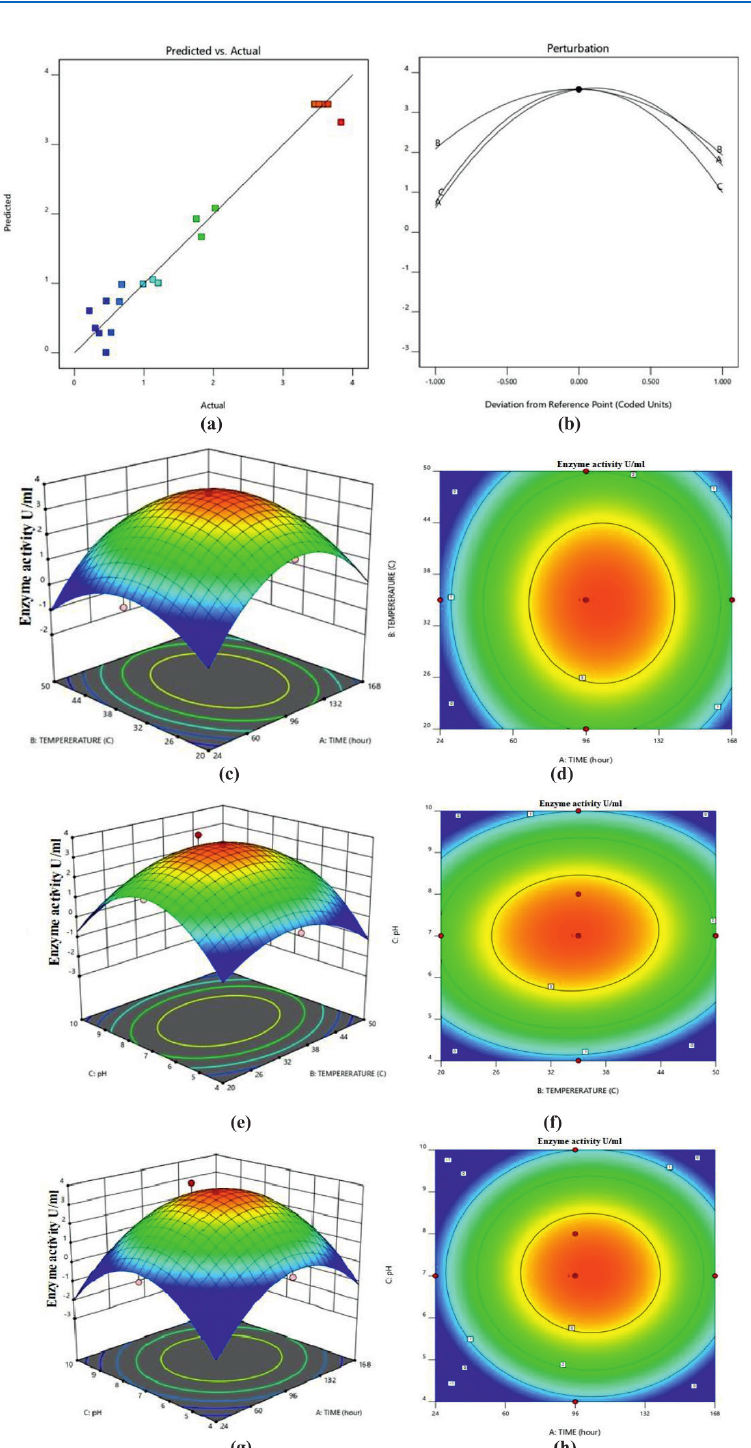
Fig. 4 (a). Three factors affecting laccase production of perturbation graph, (b) Relation between actual and predictive data, (c-h) 3D and 2D interaction plot of incubation time temperature and pH for laccase